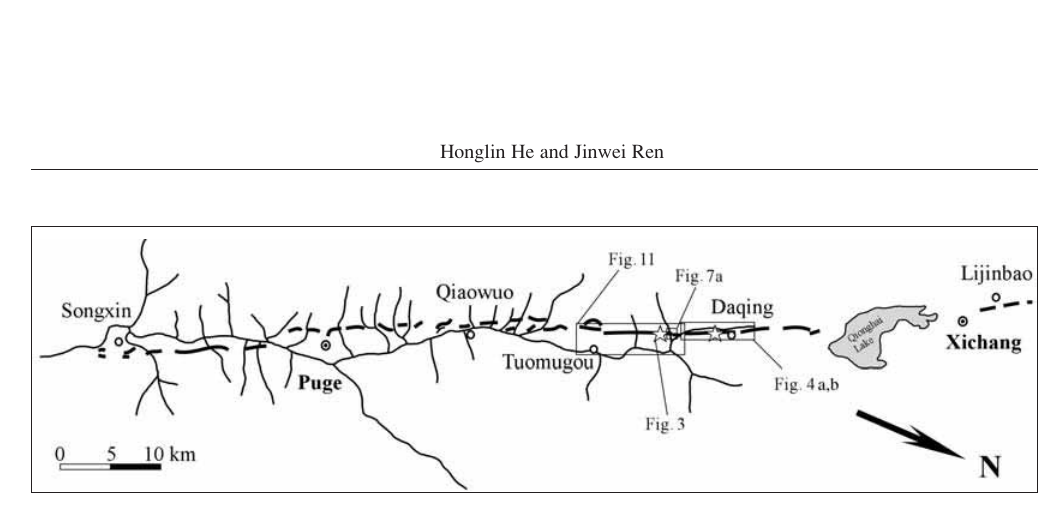
Fig. 2. Map of surface rupture associated with the A.D. 1850 earthquake. Thick lines show the location of the active trace, while the thin lines show the drainage of the Zemuhe River.